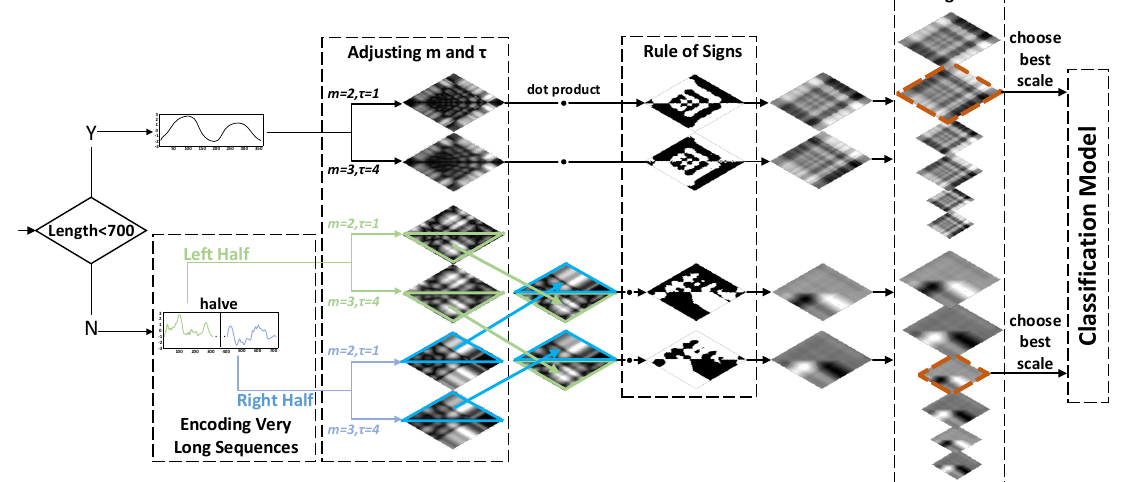
Figure 2. The architecture of our proposed MS-RP. The x -axis and y -axis of time series represent the length and the amplitude,